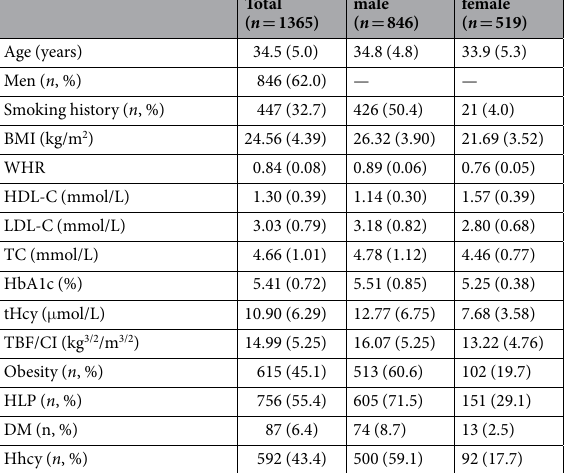
Table 1. Participants’ clinical characteristics. Continuous data were shown as mean (SD) and categorical data were n (%). BMI: body mass index; WHR: waist-hip ratio; HDL-C: high-density lipoprotein-cholesterol; LDL-C: low-density lipoprotein-cholesterol; TC: total cholesterol; HbA1c: hemoglobin A1c; tHcy: total homocystein; TBF/CI: total body fat/conicity index; HLP: hyperlipidemia; DM: diabetes mellitus; Hhcy: hyperhomocysteinemia.